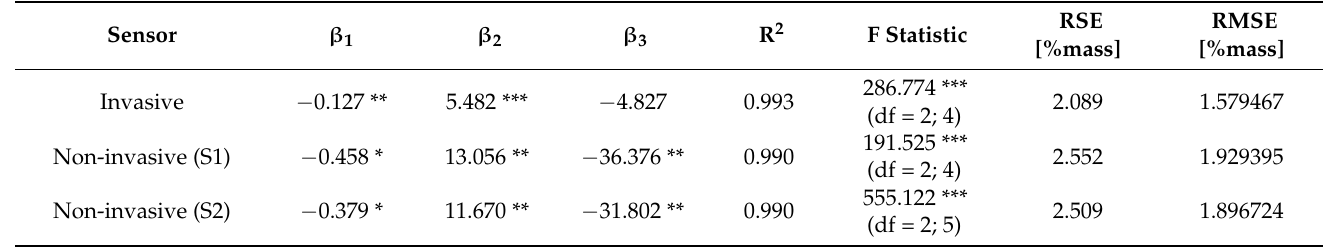
Table 8. Estimator values of the adopted calibration models of the measuring probes used (600 c.c.